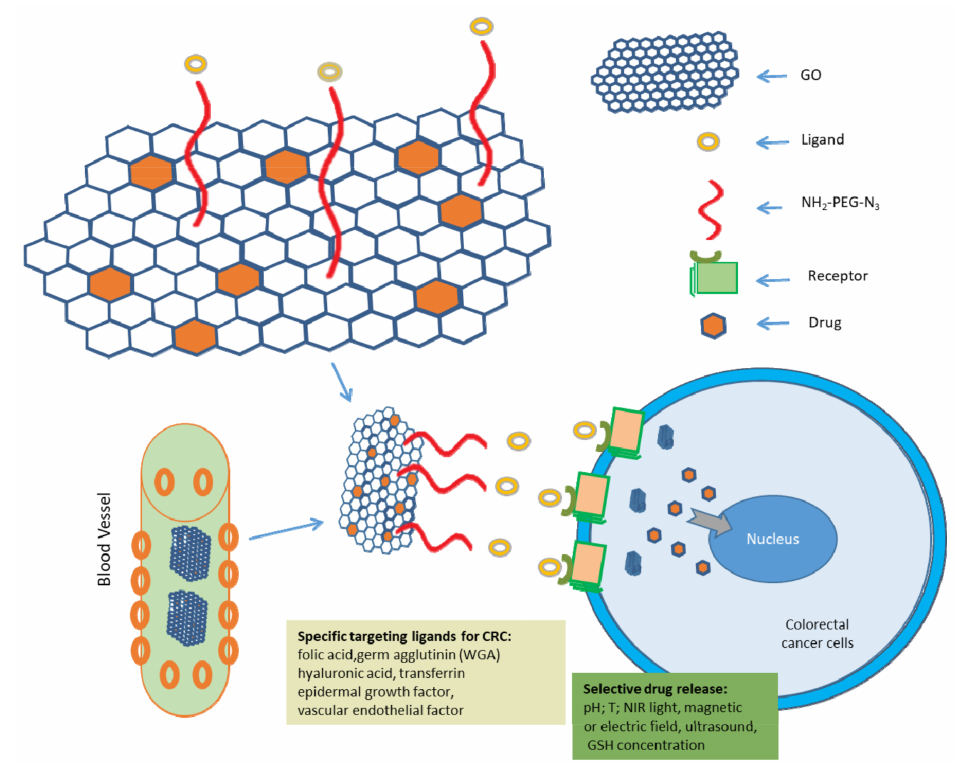
Figure 5. Schematic diagram of the mechanism of targeted drug delivery in colorectal cancer cells. Graphene oxide nanoparticle (GO) NPs are loaded with the drug and a specificlig and to bind specifically to colorectal cancer cells. Drugs released from GO carriers in CRC cells are triggered internally by cellular changes in the pH and redox or exogenous stimuli such as near-infrared (NIR) light, ultrasound, and magnetic and electric